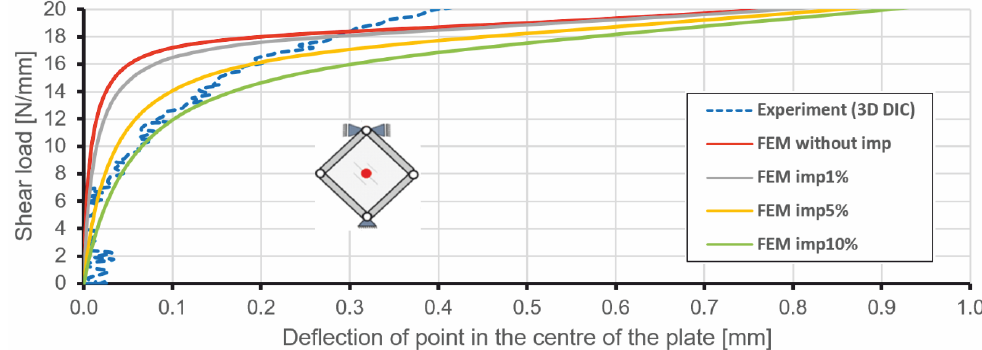
Figure 11. Load versus central point deflection obtained for the stiffened plate by numerical calculations and experimental investigations.